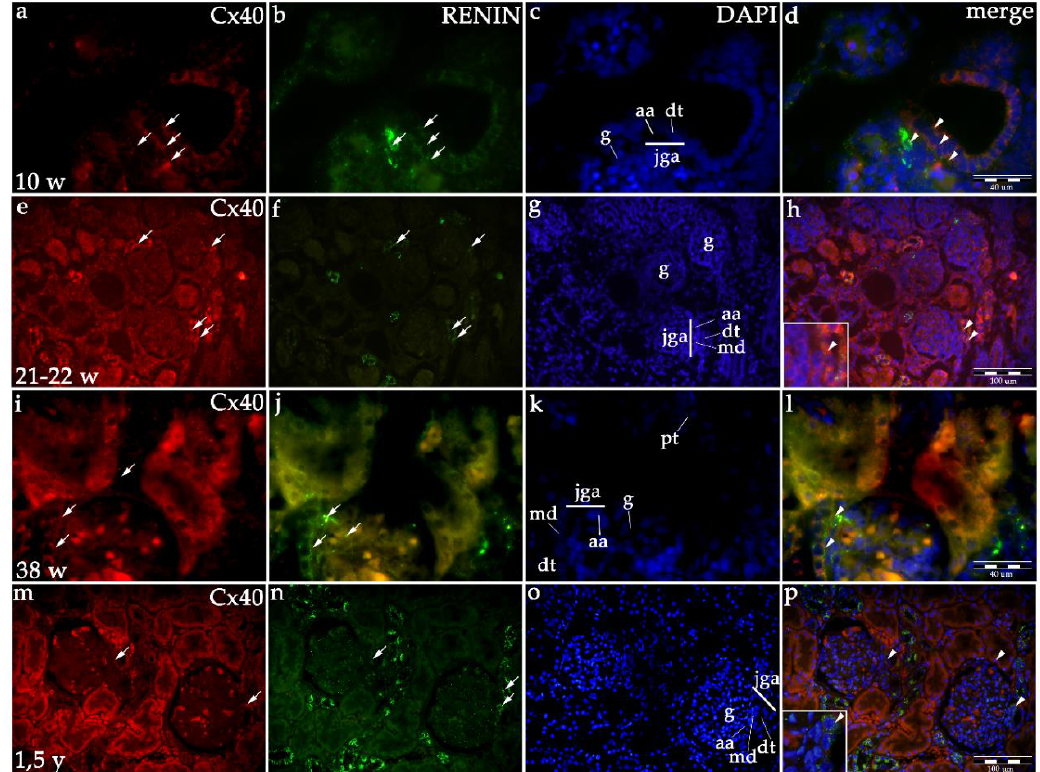
Figure 2. Co-expression of Cx40 and renin in the JGA region of developing and healthy postnatal human kidneys: kidneys in the 8th developmental week ( a – d ); kidneys in the 21–22nd developmental week ( e – h ); kidneys in the 38th developmental week ( i – l ), healthy postnatal human kidneys ( m – p ). Glomeruli (g), afferent arteriole (aa), macula densa (md), juxtaglomerular apparatus (jga), proximal tubule (pt), distal tubule (dt). Cxs or renin expression (arrows), DAPI nuclear stain ( c , g , k , o ). Merged microphotographs of different Cxs with renin (merge) show their co-expression (arrowheads) in the JGA ( d , h , l , p ). Double immunofluorescence staining of DAPI nuclear stain with Cx40/renin magnification ×40, scale bar 100 μm ( h , p ), ×100, scale bar 40 μm ( d , l ).